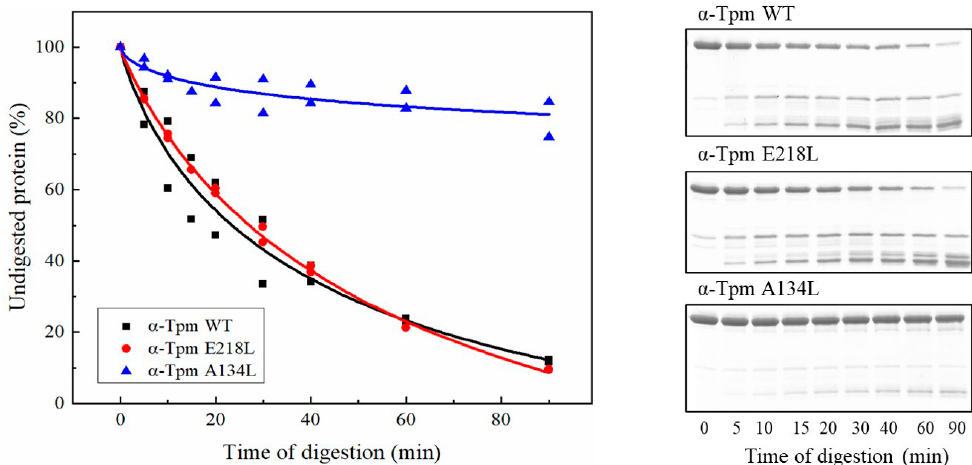
Figure 1. SDS-PAGE gels ( right ) and the time course of tryptic digestion ( left ) of A134L and E218L tropomyosin (Tpm) in comparison with WT Tpm. Trypsin:Tpm weight ratio was 1:150. Tpm concentration was 0.5 mg/mL; the reaction was carried out at 30 °C in 30 mM Hepes-Na buffer, 100 mM NaCl, 1mM MgCl 2 , pH 7.3.